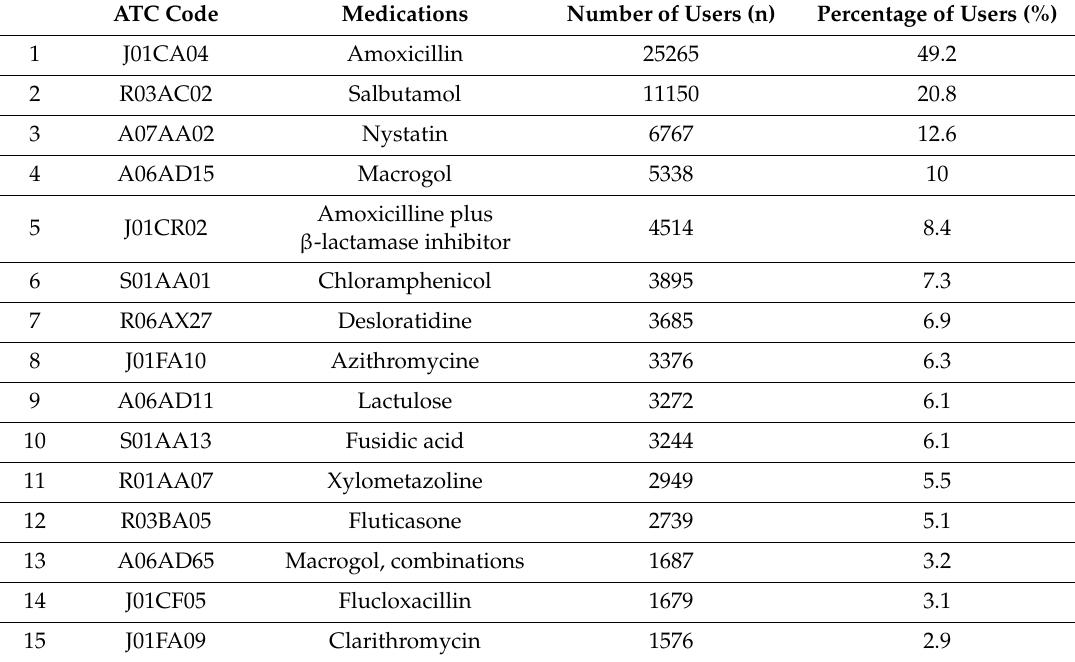
Table 2. The 15 most dispensed medications, with their ATC codes, number of users and percentage of users (calculated on the total amount of patients, in the age group of 0 until and including 5